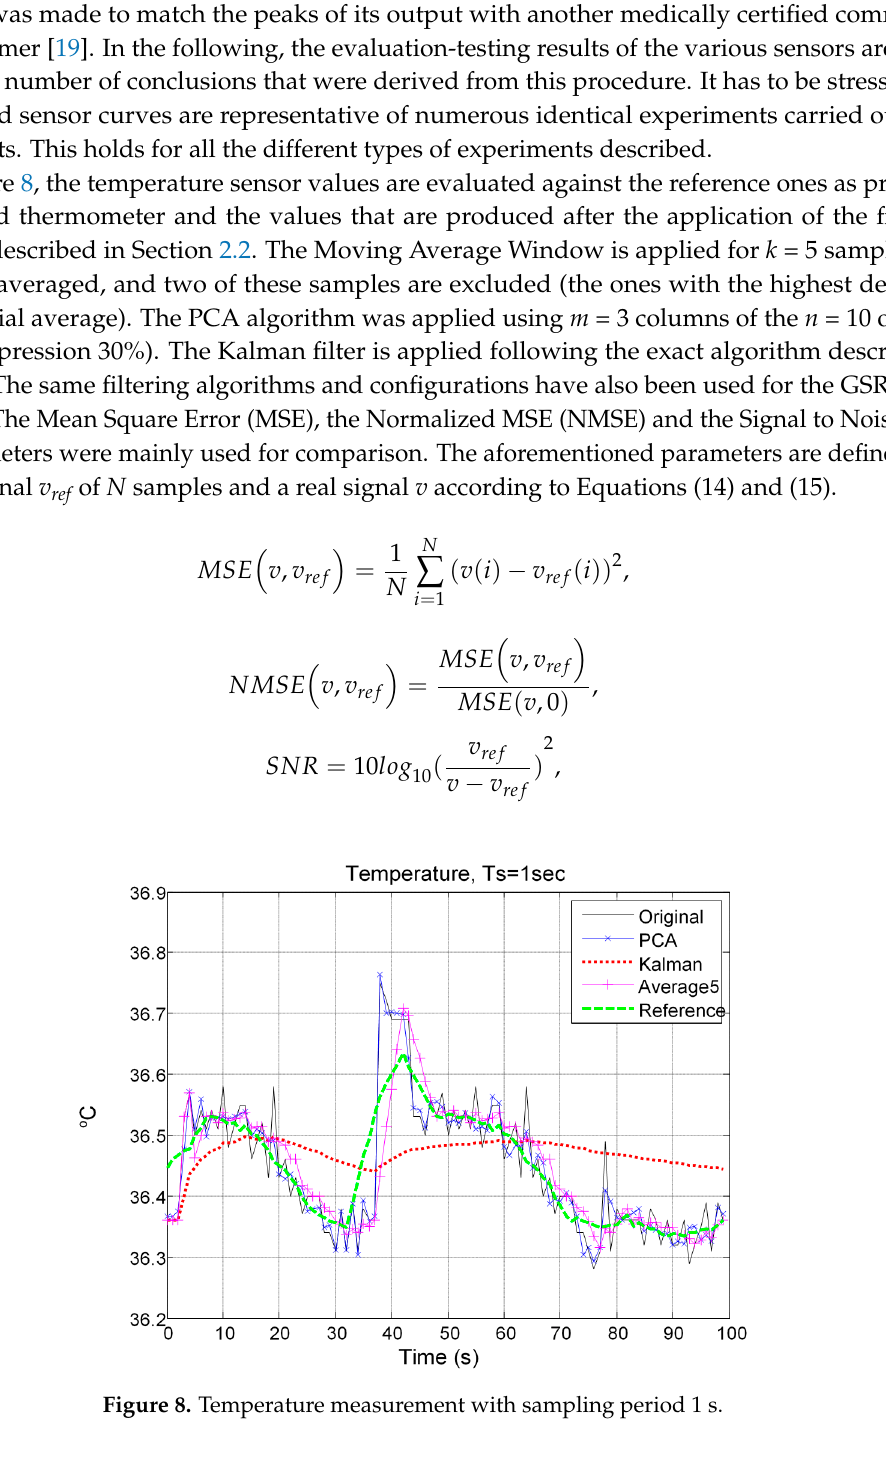
Figure 9. Skin Conductance Voltage Measurement with sampling period 500 ms.